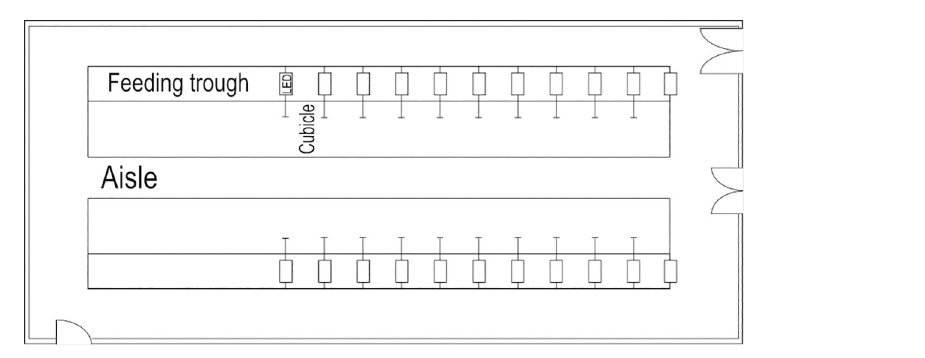
Fig 1. Layout of the Light lab. LED fixtures placed on each side of the head of every